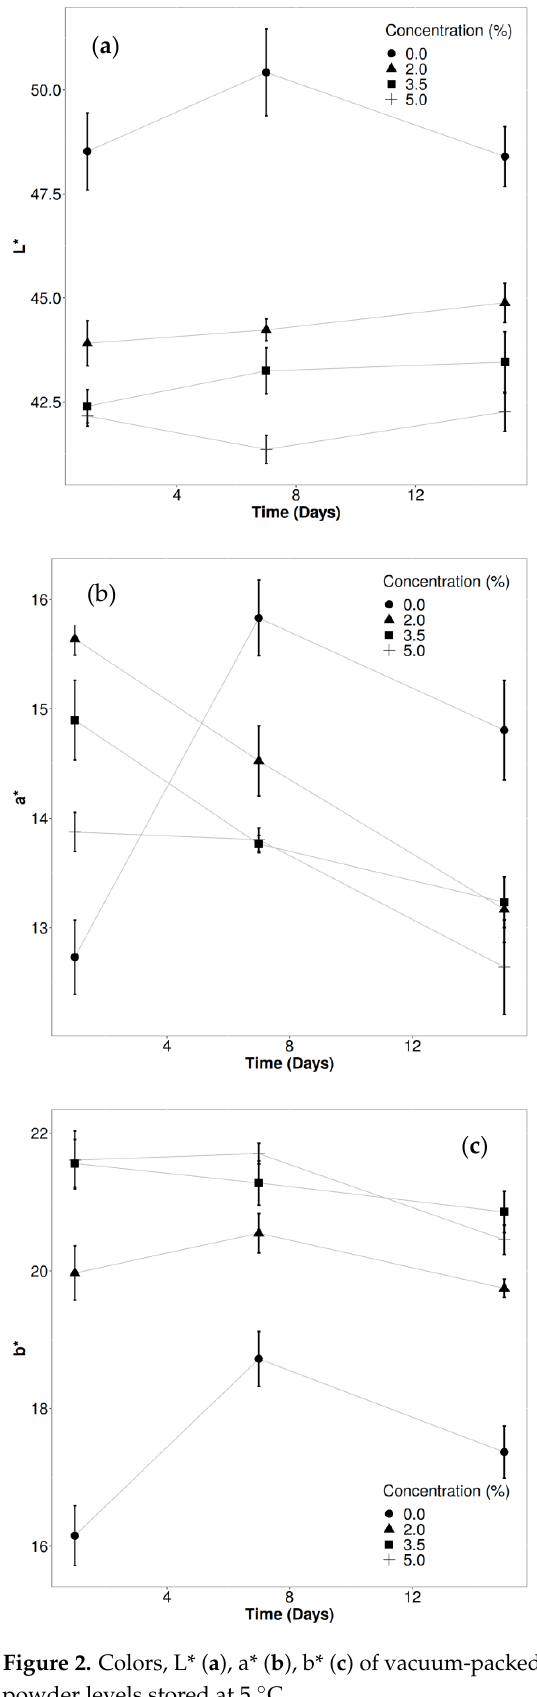
Figure 2. Colors, L* ( a ), a* ( b ), b* ( c ) of vacuum-packed ground beef containing different camu-camu powder levels stored at 5 °C.